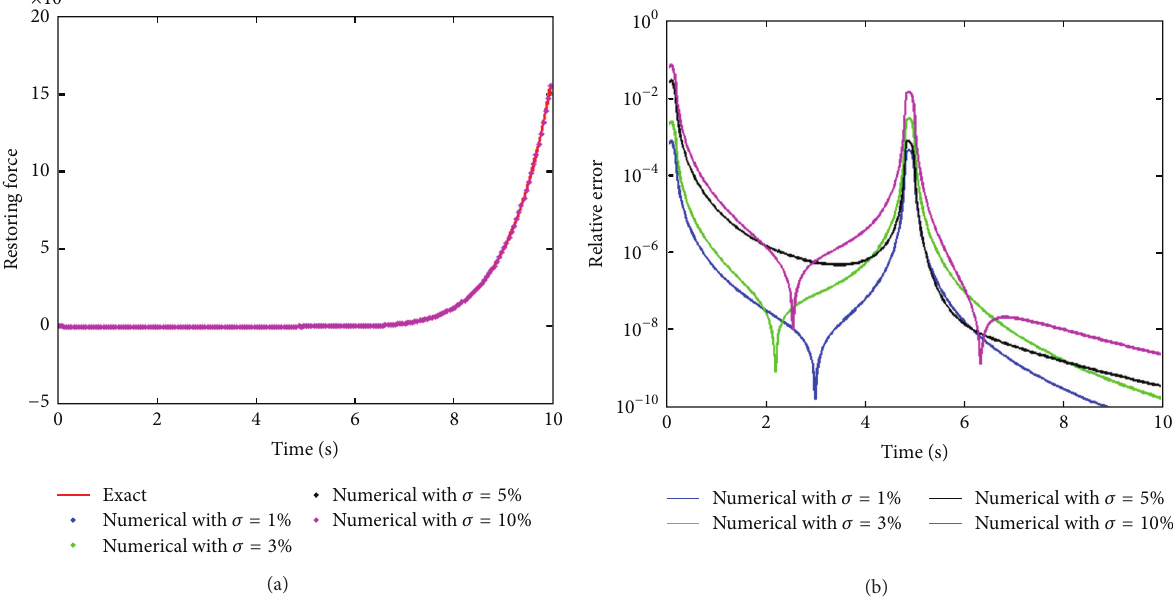
Figure 10: For Example 2, (a) comparing estimated and exact restoring forces and (b) displaying the error of estimation with 𝜎 = 1 %, 3%, 5%, and 10%,